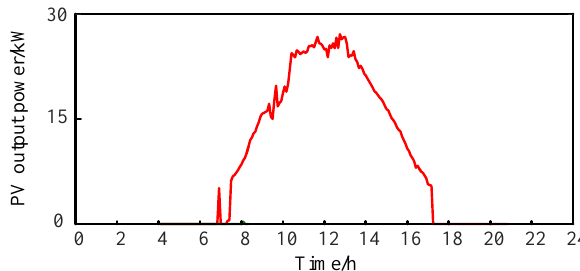
Figure 7. Figure 7.